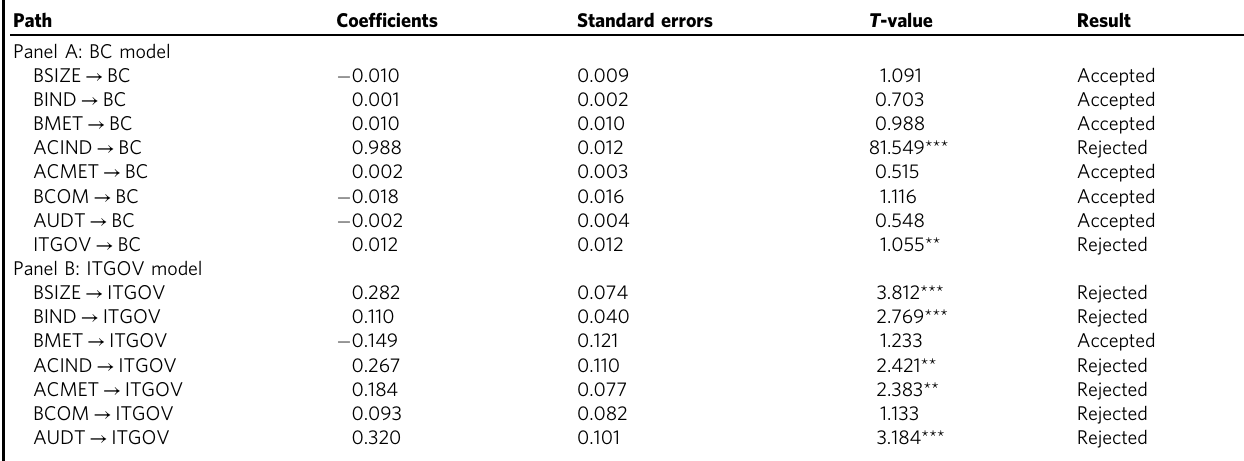
Table 7 Structural equation